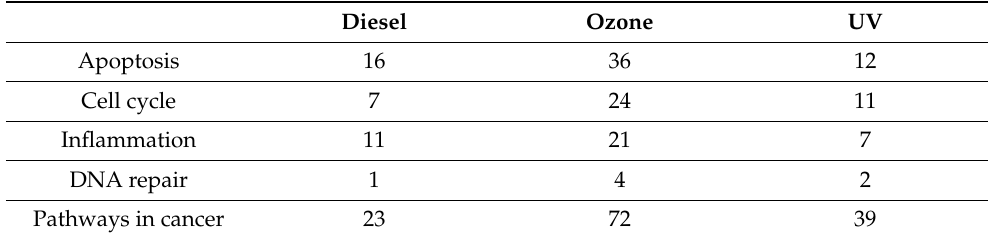
Table 4. Number of the miRNAs involved in the pathways deregulated by each pollutant tested. Only miRNAs demonstrated to be involved in the pathways are